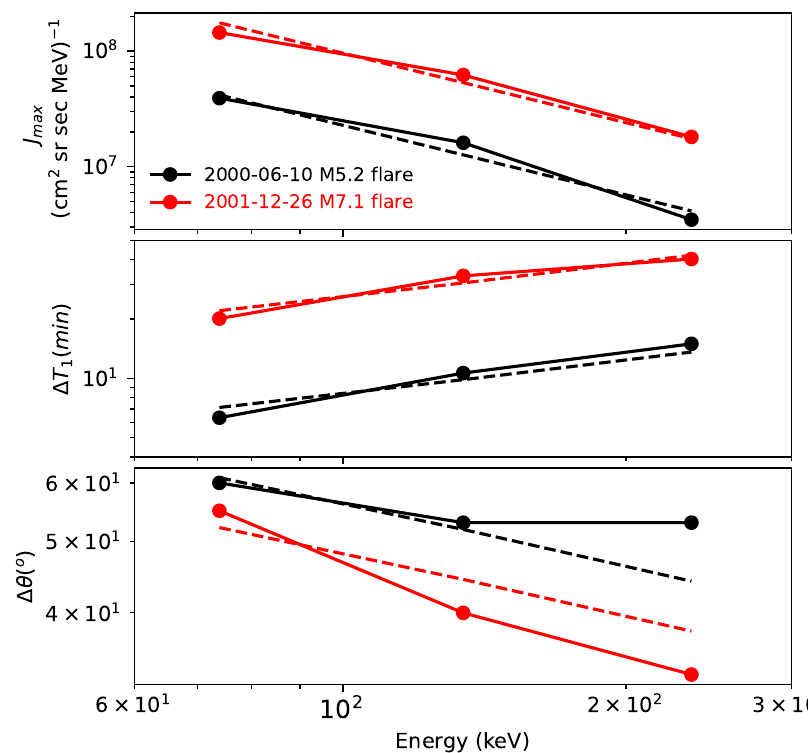
Figure 13. From top to bottom: the maximum value of the particle source intensity I max , the time interval from the onset time of the flare to the peak time of the particle source, ∆ T 1 , and the half width of the particle source ∆ θ , with different energy for the two SEP events. Solid circles connected by solid lines indicate the best fit parameters, and the dashed lines indicate the modelling results. Black and red indicate the SEP events of 10 June 2000 and 26 December 2001,